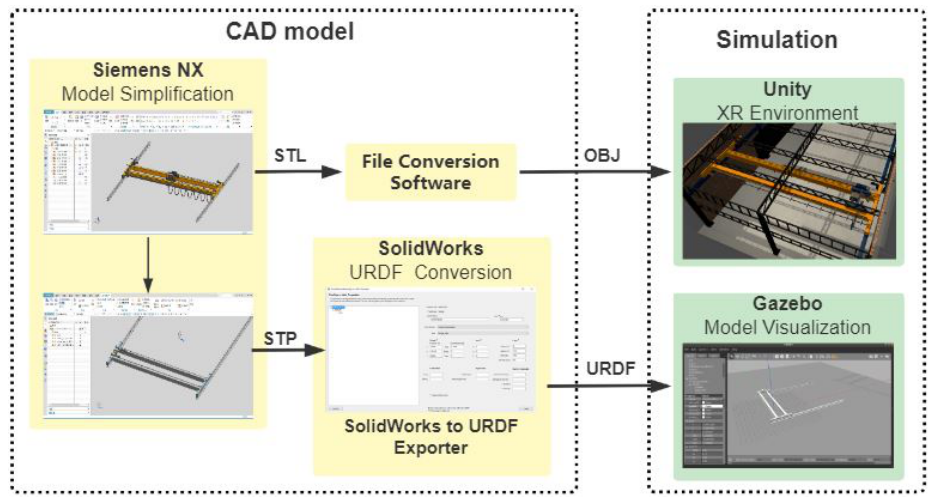
Figure 3. Workflow of the model conversion from CAD to Unity and Gazebo. It involves two sub workflows, CAD model to Unity and CAD to Gazebo with the corresponding file